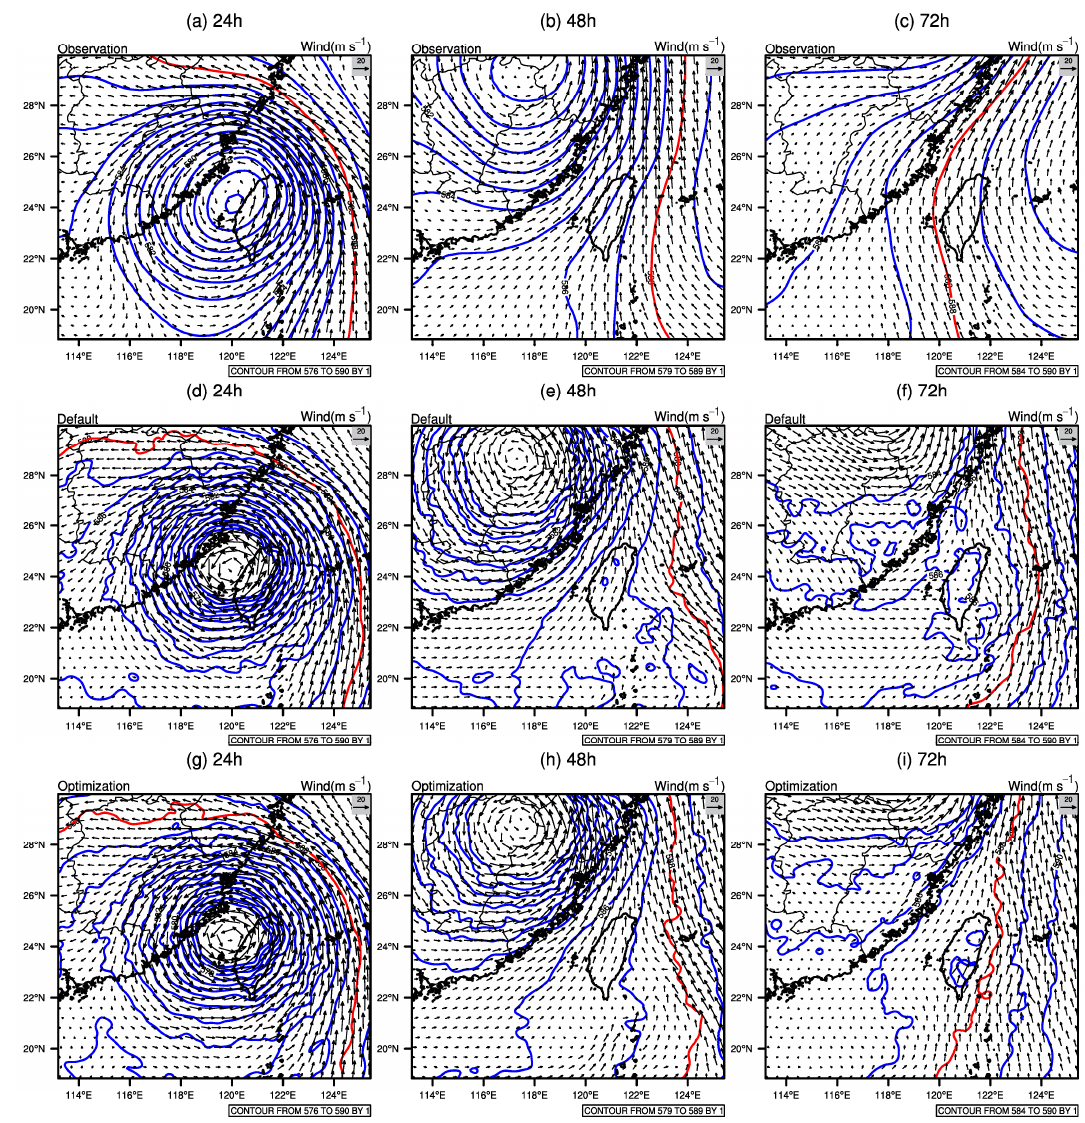
Figure 10. Same as in Figure 9, except using event (5). ( a )–( c ) represent the observed 500 hPa high-altitude fields at 24, 48, and 72 h lead times respectively; ( d )–( f ) represent the simulated 500 hPa high-altitude fields with default parameters at 24, 48, and 72 h lead times respectively; ( g )–( i ) represent the simulated 500 hPa high-altitude fields with optimal parameters at 24, 48, and 72 h lead times respectively.